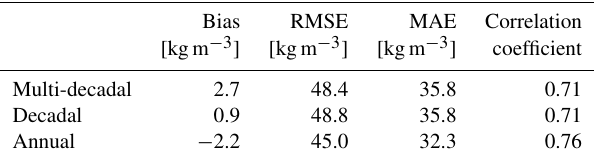
Table 1. Summary of calculated validation parameters for three snow density sets for the years